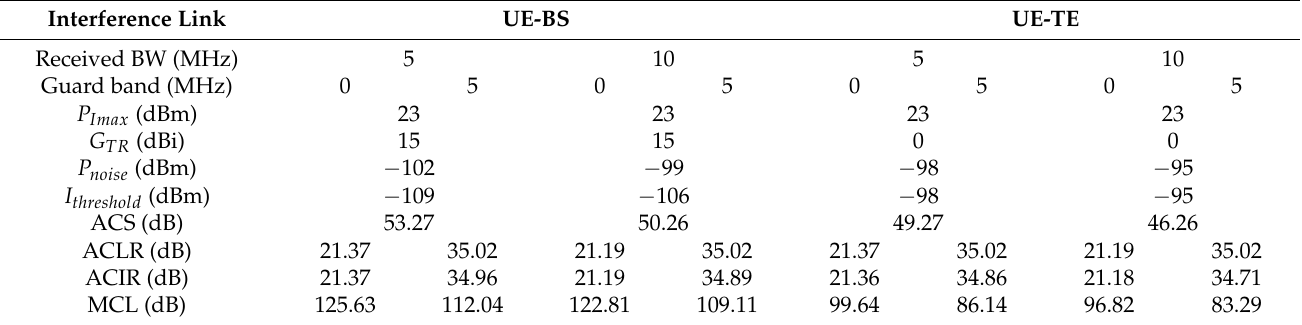
Table 2. Interference calculation parameters of LTE-M with directional antenna radiations